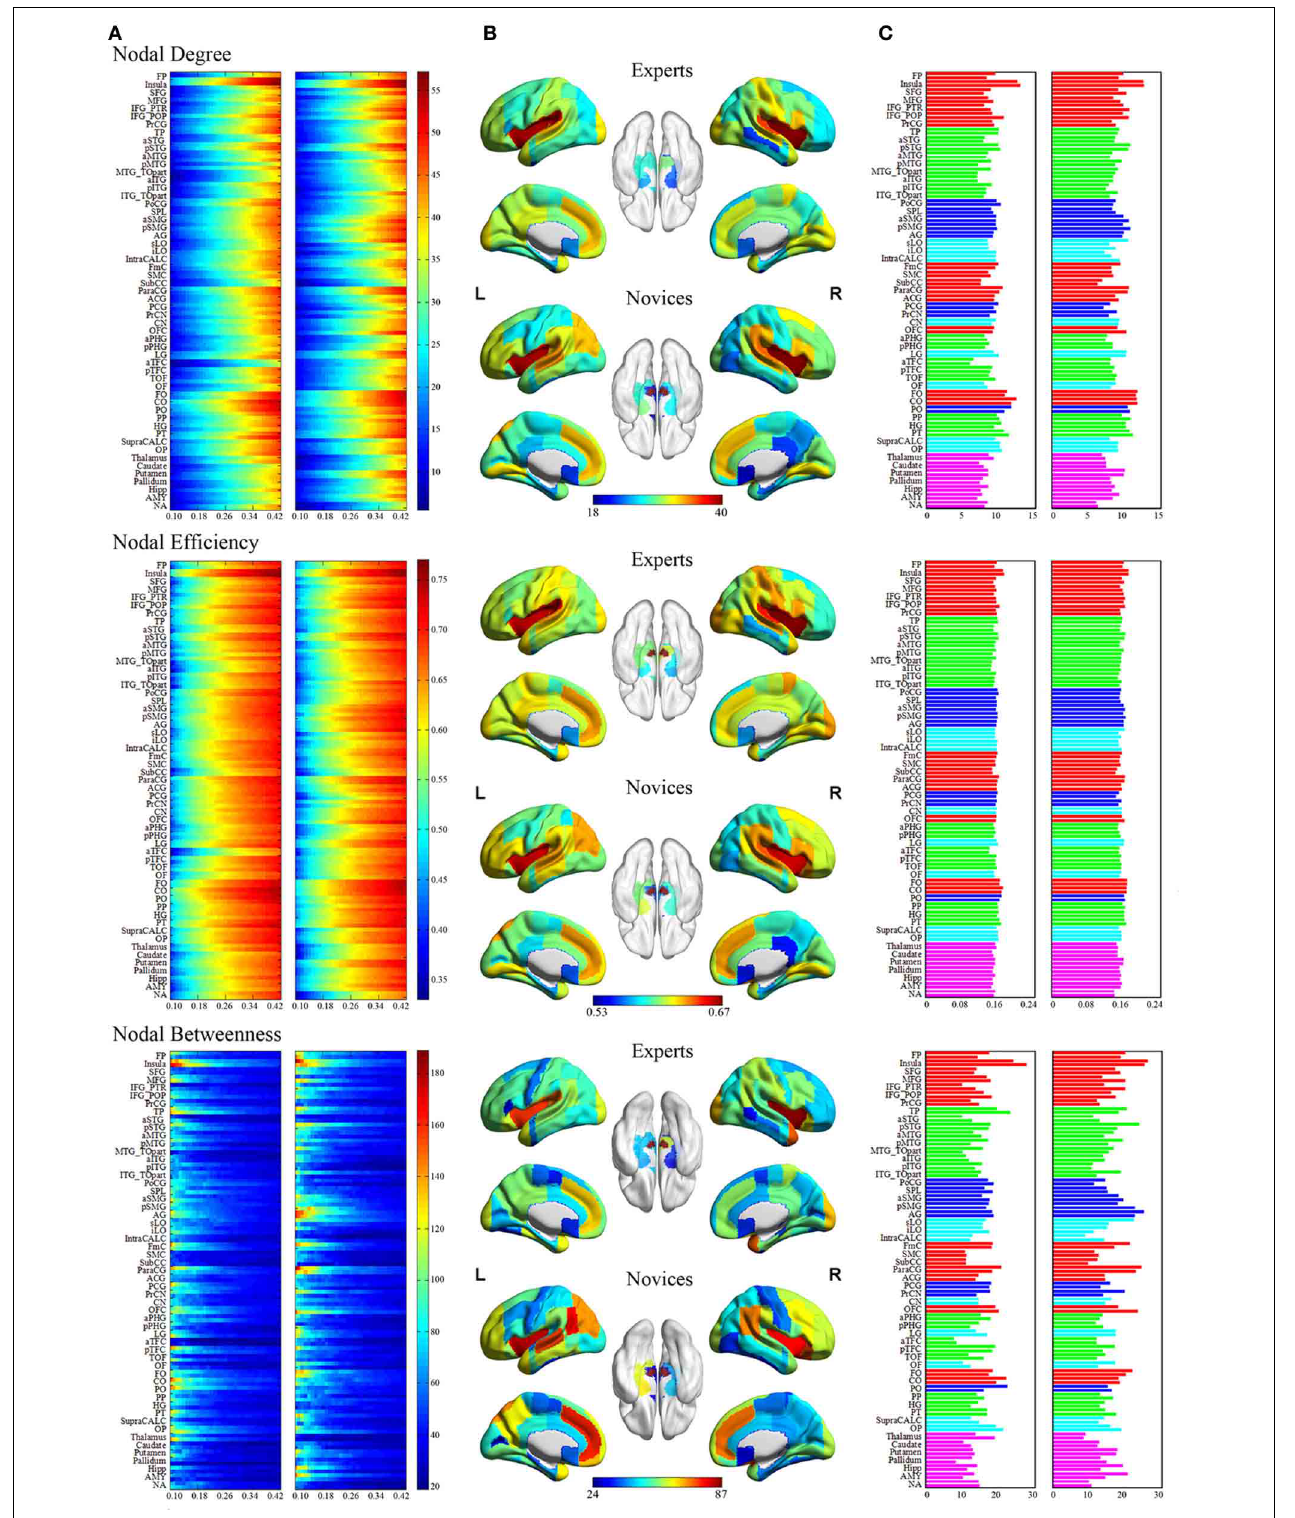
FIGURE 4 | Regional network measures (i.e., nodal degree, nodal efficiency, and nodal betweenness) for experts and novices. (Panel A ) shows values of each nodal metric over a range of thresholds in each group. (Panel B )showsmeanvaluesforeachnodalmetricacrossarangeofthresholds